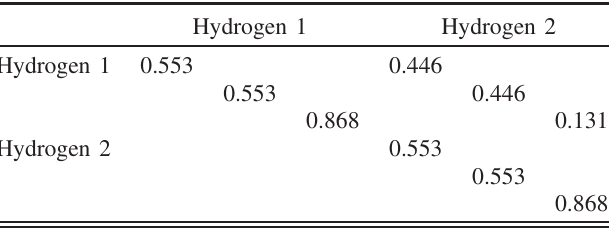
97 . 2 pm and ∠ ð HOH Þ ¼ 104 . 5 °]. The sum rule OH ¼